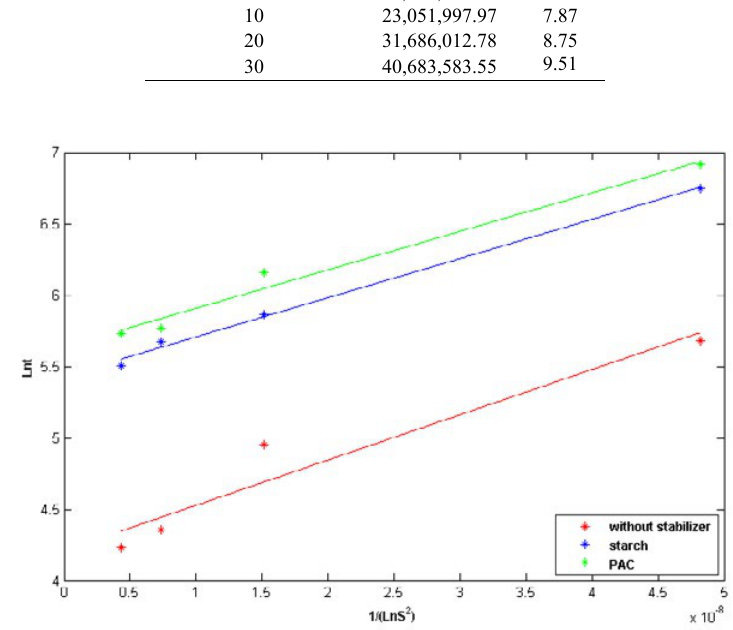
Fig. 7. BaSO crystallization in different polymers on primary nucleation theory 4 Table 5. Interfacial tension in various concentration Polymers